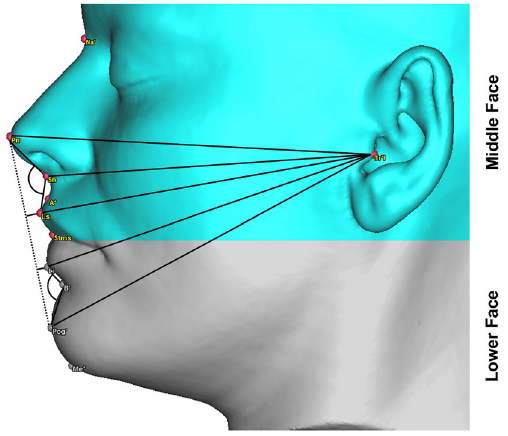
Figure 4. Angular and linear measurements of the middle (green) and lower (grey) third of the face in the profile view.